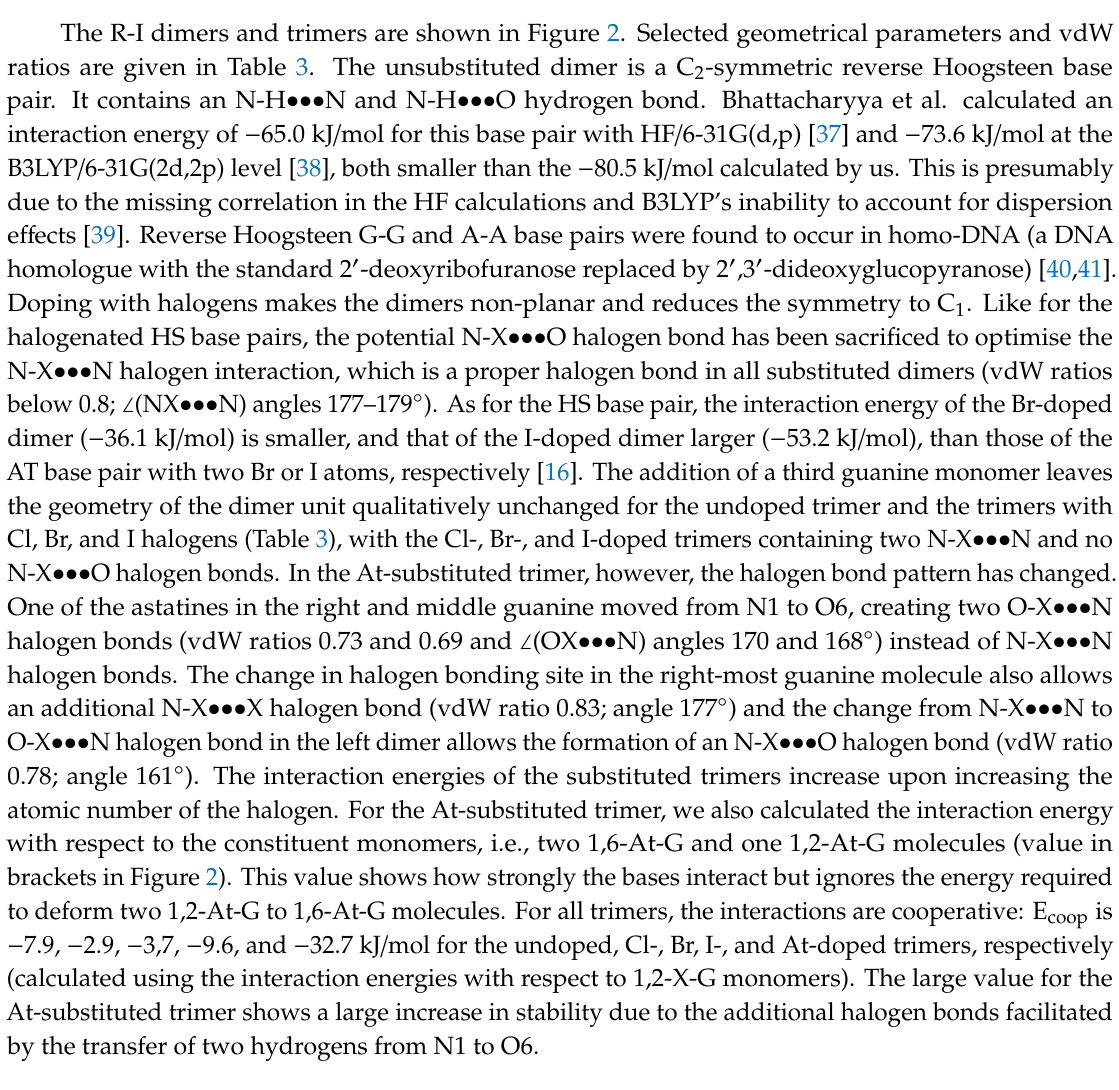
Table 3. Selected geometrical parameters (distances in Å; angles in degrees) and van der Waals ratios (vdW) for the R-I dimers and